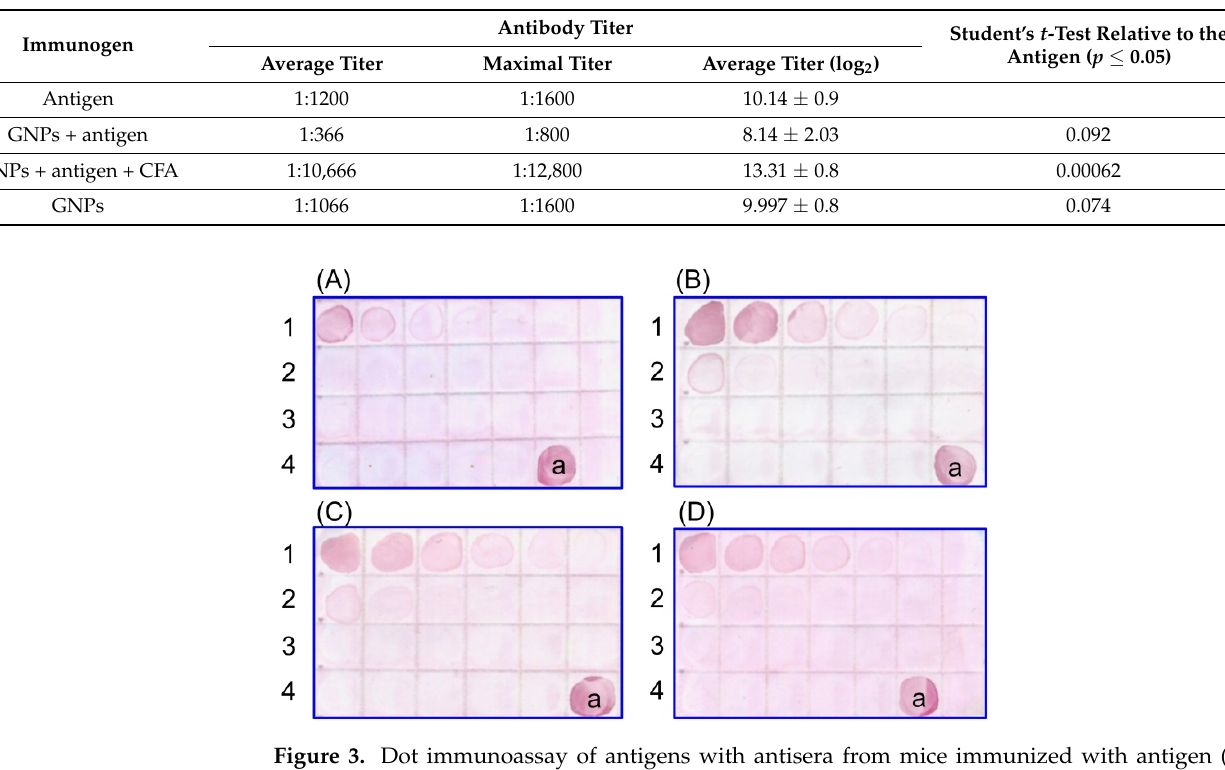
Table 1. Antibody titers produced by different immunization schemes after tumor cell transplantation.